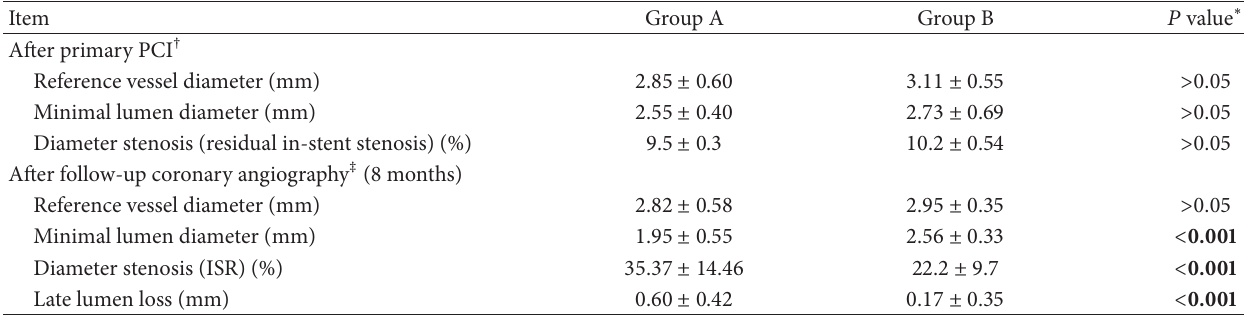
Table 3: Quantitative coronary angiography results: baseline and 8-month follow-up.